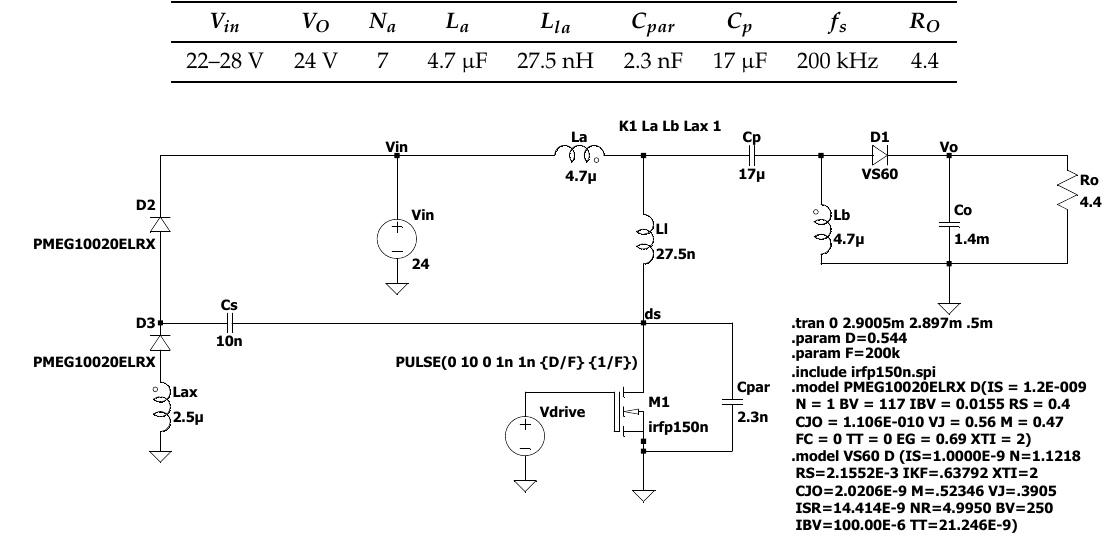
Figure 7. Simulation setup for SEPIC